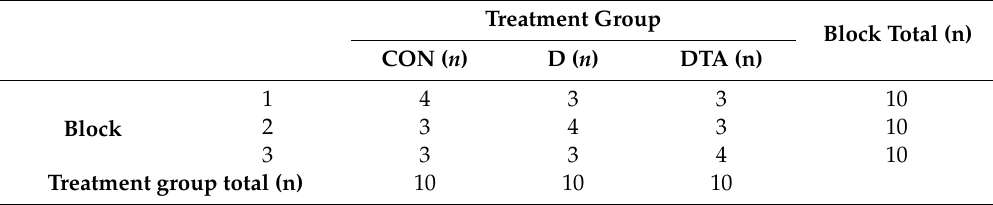
Table 1. Number of animals in each block and treatment group (sham scoop dehorning, CON; scoop dehorning, D; and scoop dehorning with topical anaesthetic,